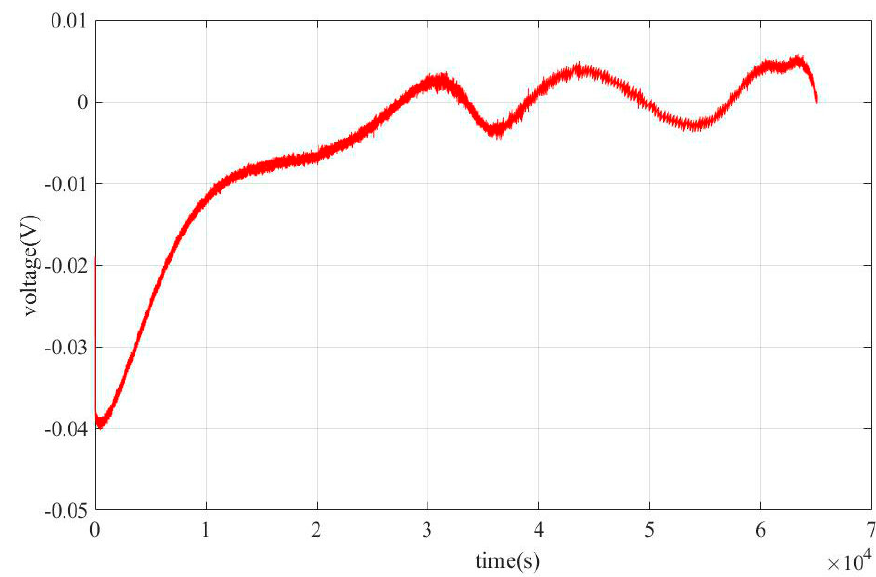
Figure 3. Curves at low-current OCV.